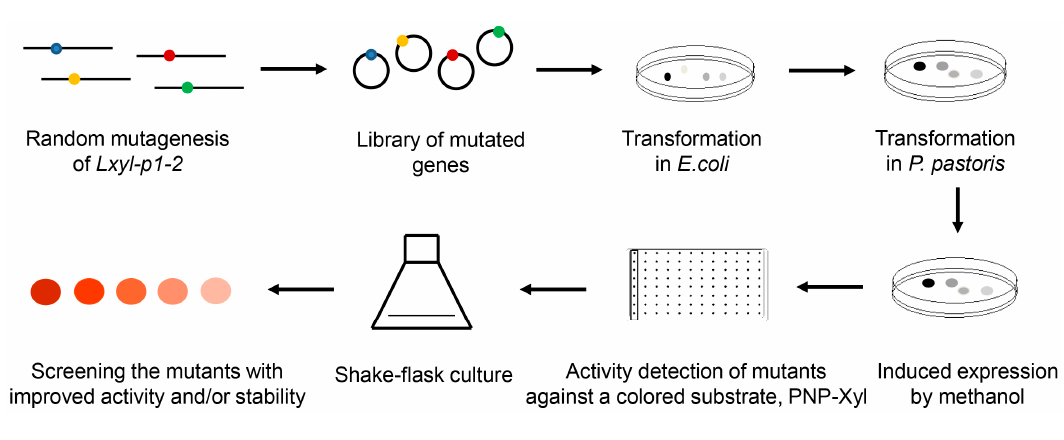
Figure 1. Flow chart of the screening process.